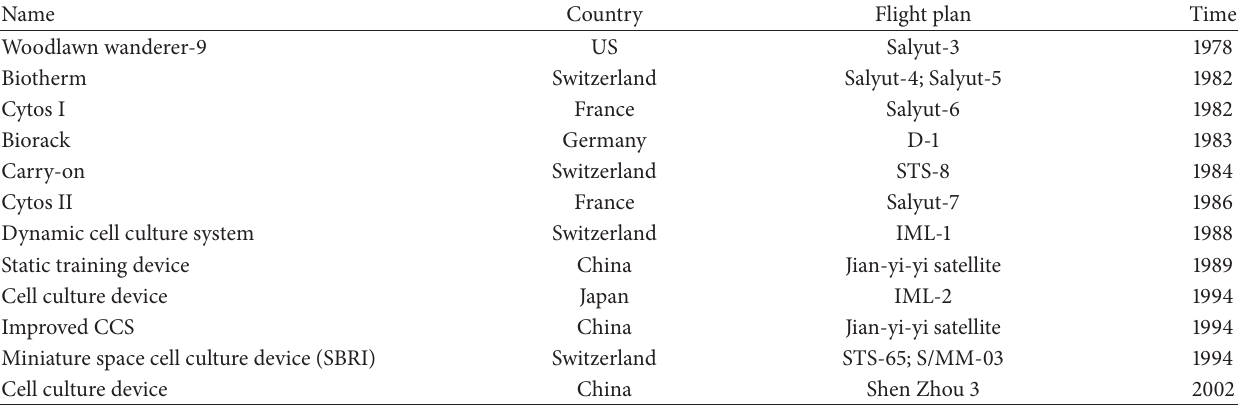
Table 1: Space cell culture instruments development at home and